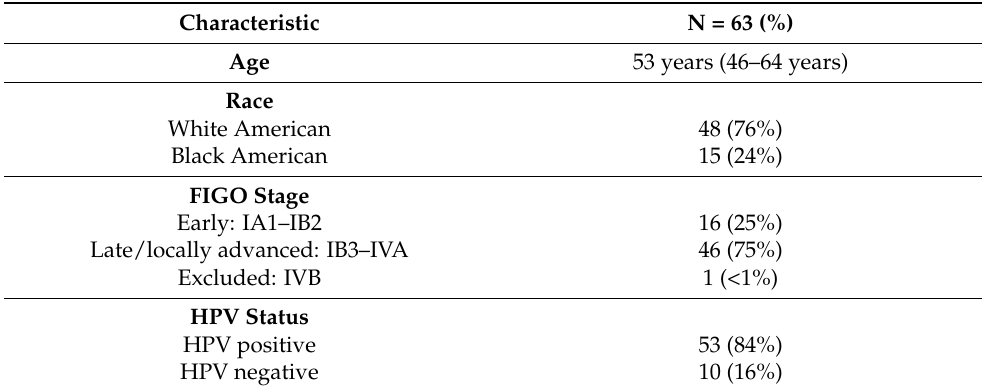
Table 1. Summary statistics for all samples filtered from GSE151666. Patients of Asian or Hispanic ancestry were excluded from the downstream